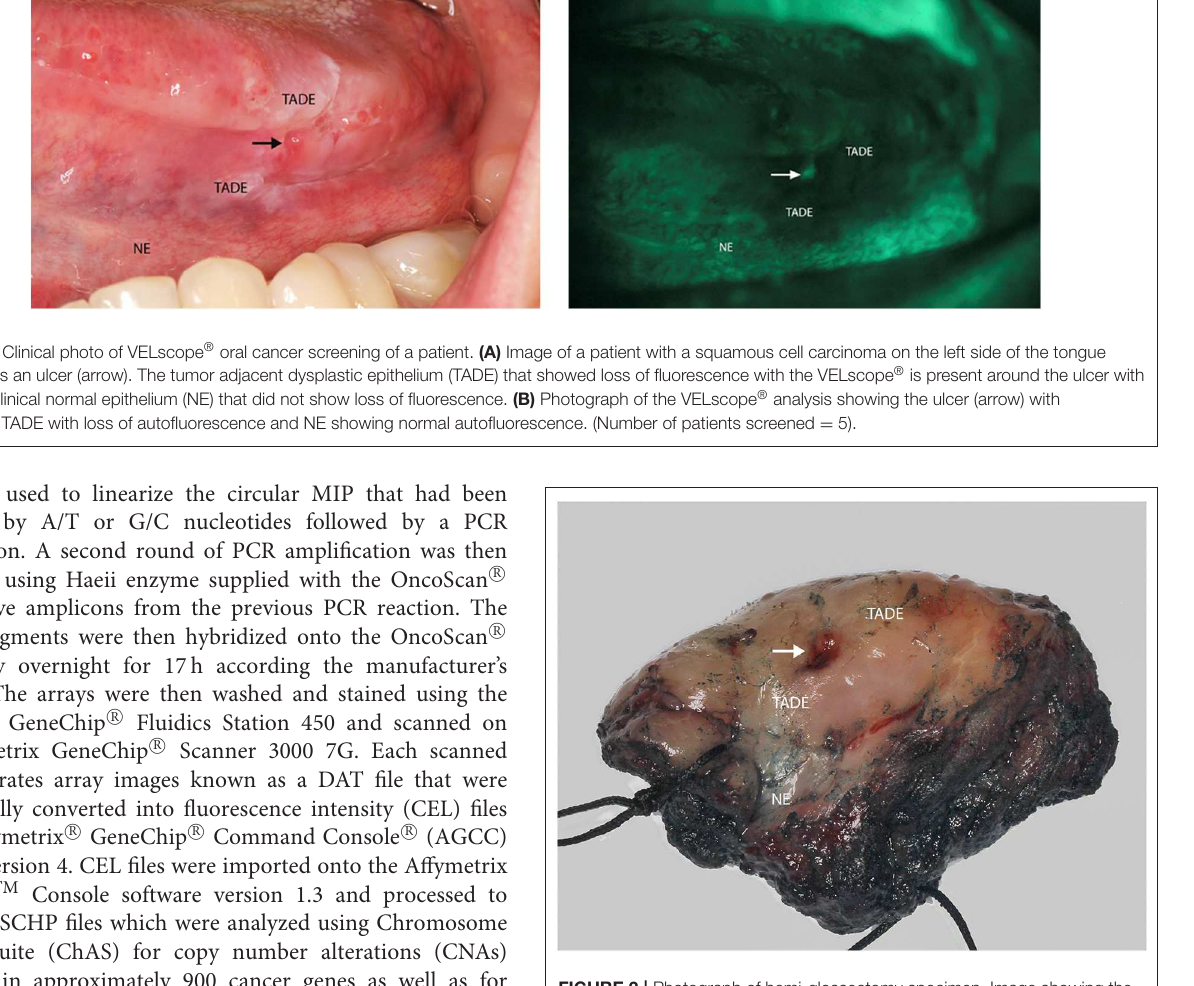
FIGURE 2 | Photograph of hemi-glossectomy specimen. Image showing the carcinoma (arrow) as well as the TADE and NE areas (as determined previously using the VELscope ® , number of patients screened =